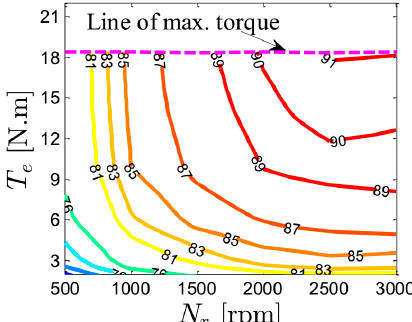
Figure 29. Measured efficiency map of the whole drive system using the S-PM machine at optimal current angles.